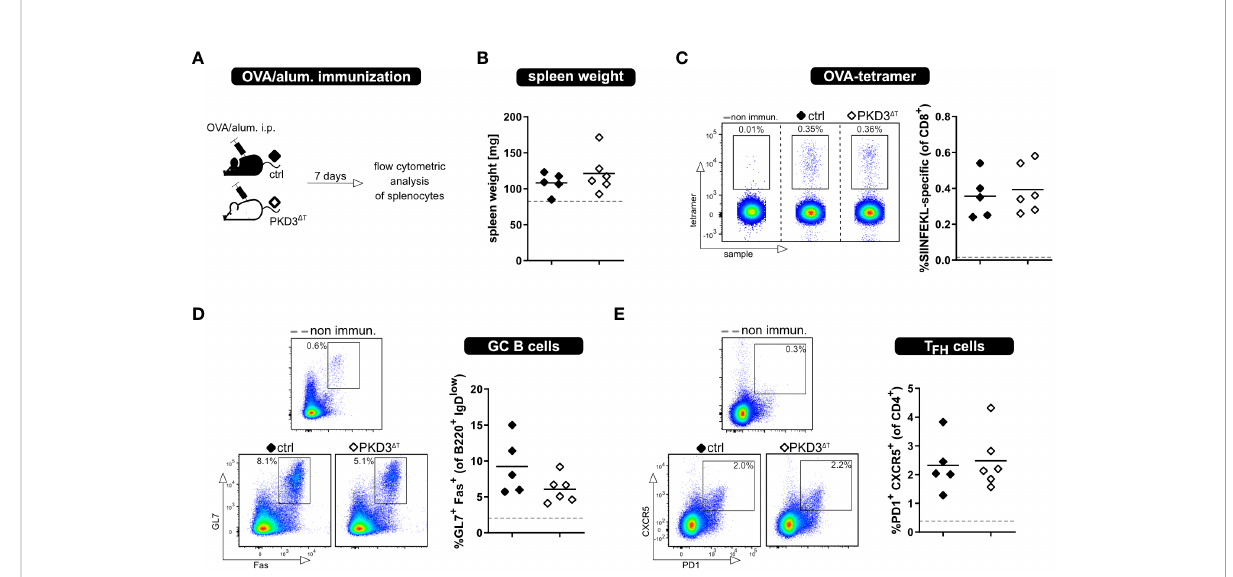
FIGURE 4 Loss of T cell-intrinsic PKD3 does not affect adaptive immune response upon immunization. PKD3 D T mice ( ⬦ ) and respective controls ( ♦ ) were immunized i.p. with OVA/alum. Immune response was analyzed after 7 days. (A) Experimental set-up (B) Spleen weight (C-E) Frequency of SIINFEKL-speci fi c T cells, GC B cells and T FH cells analyzed by fl ow cytometry. Data from non-immunized controls are represented by a gray dashed line. (n = 5 – 6 for immunized mice, n = 2 for controls; from 2 independent